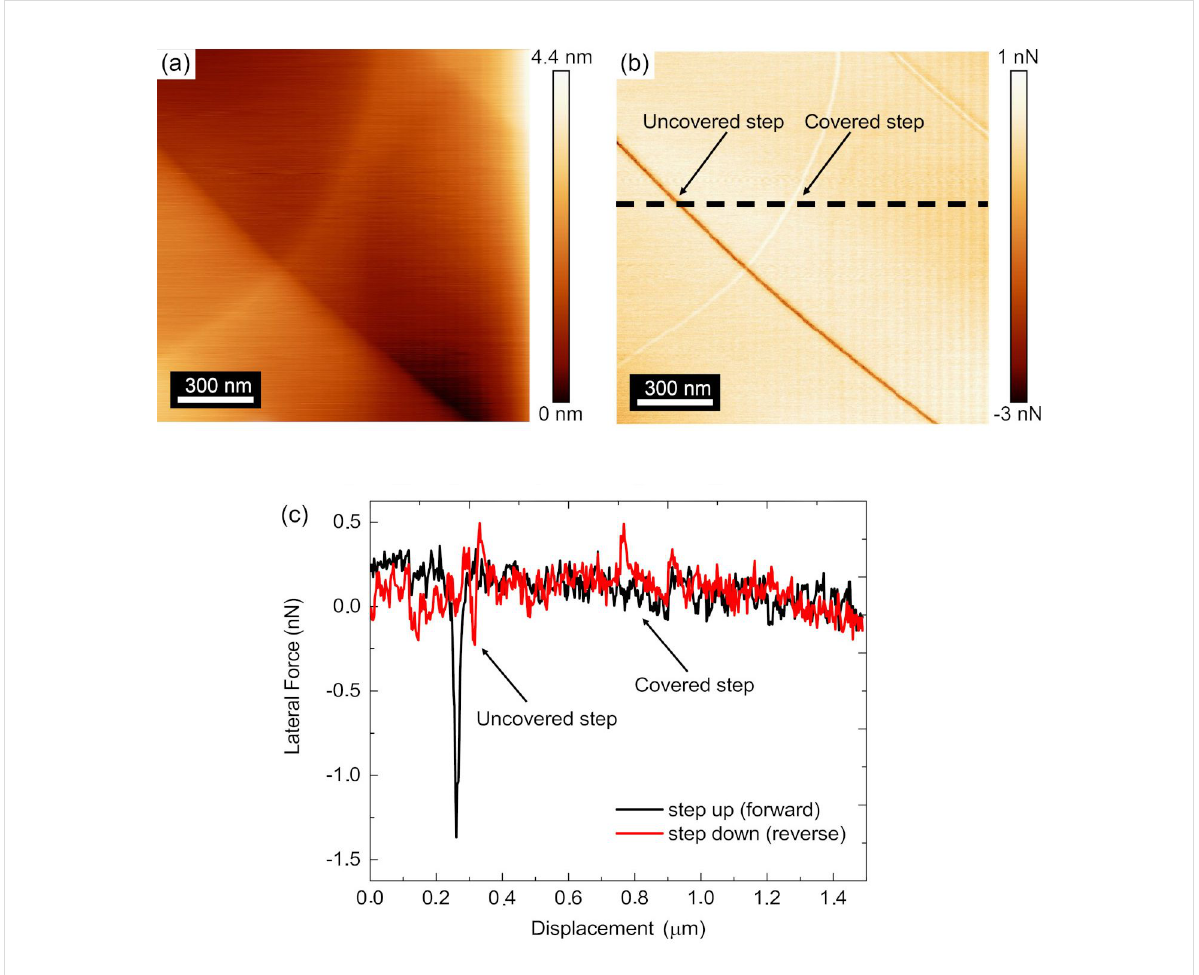
Figure 3: AFM (a) topographic and (b) reverse scan direction lateral force maps of the HOPG obtained by FMM. The covered and uncovered single atomic steps have been labeled in (a) to specify their locations. A dashed black line in (b) shows the location where the lateral force profile in (c) was obtained from, which crosses over both the uncovered and covered atomic steps. (c) Lateral force line profile of the forward and reverse scan direc- tions, highlighting the difference in the forces measured for uncovered and covered steps. The data presented in this figure were acquired with tip